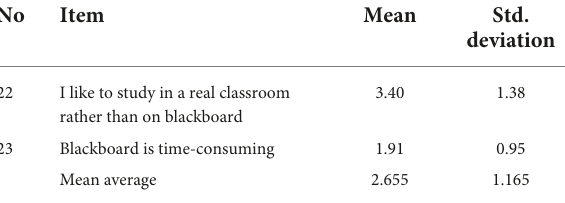
TABLE 5 Students’ negative perceptions of studying through Blackboard